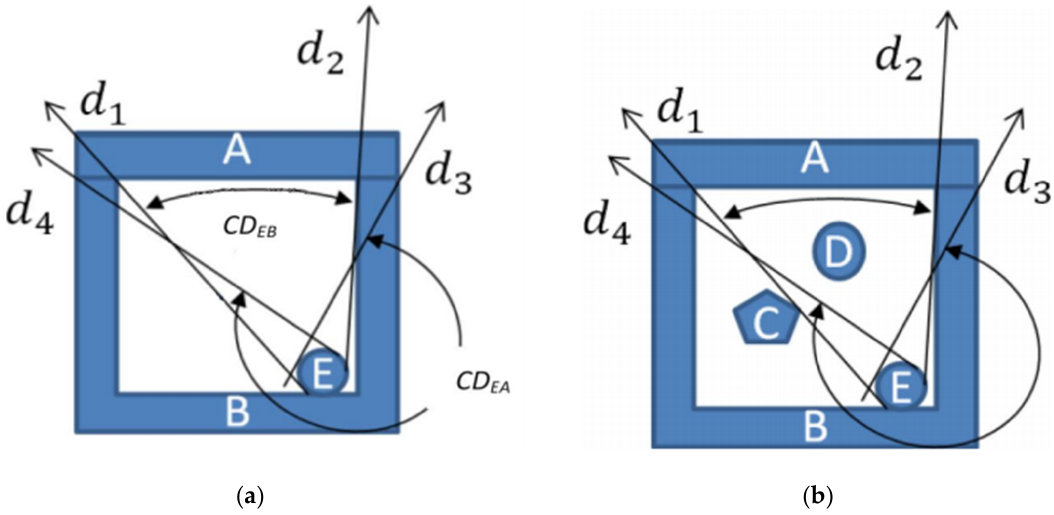
Figure 7. Constraints and Directions: ( a ) Component E removal ranges respect to component A and B; ( b ) Limits in the directions between E and A and E and B.